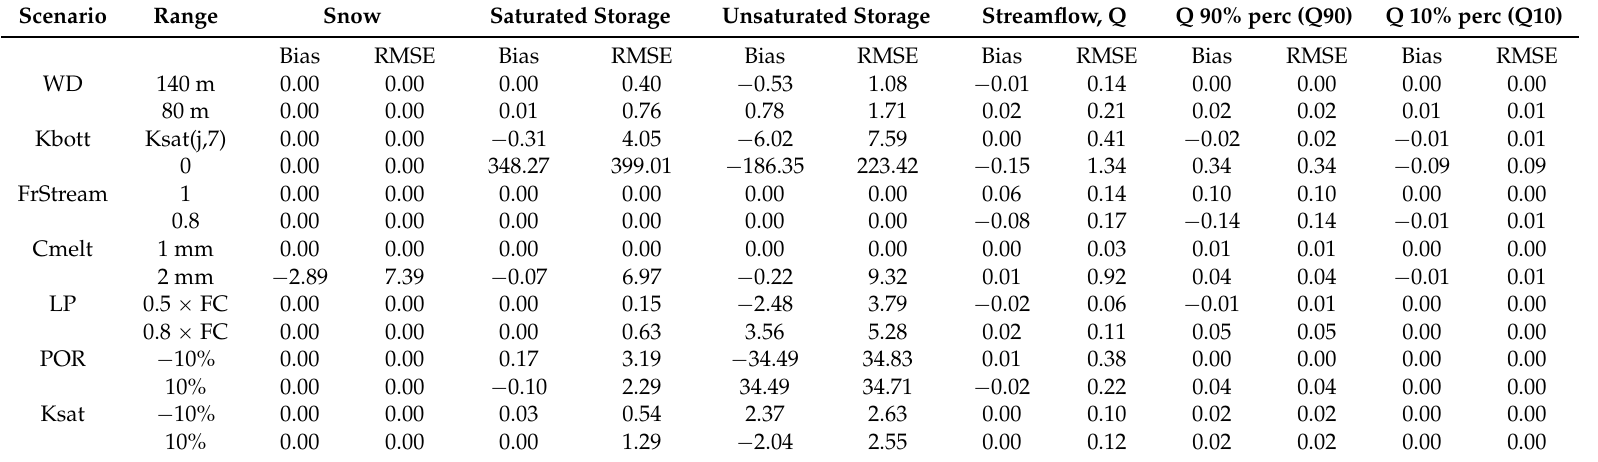
Table 2. Results of the sensitivity analysis. The values represent the difference in mm of water compared to the baseline